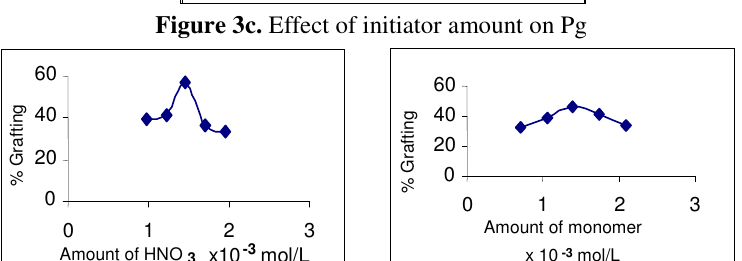
Figure 3c. Effect of initiator amount on Pg